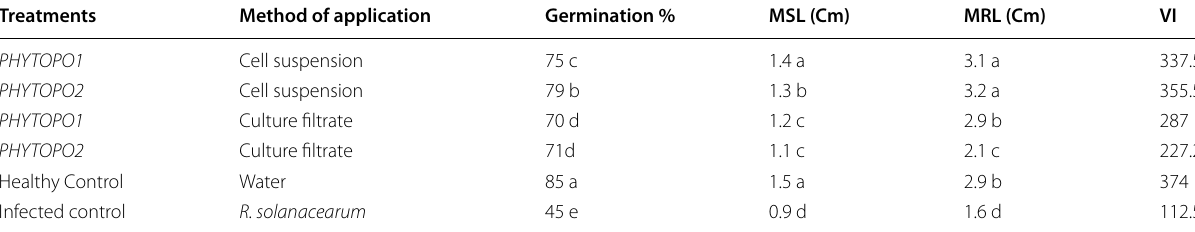
vigour of tomato